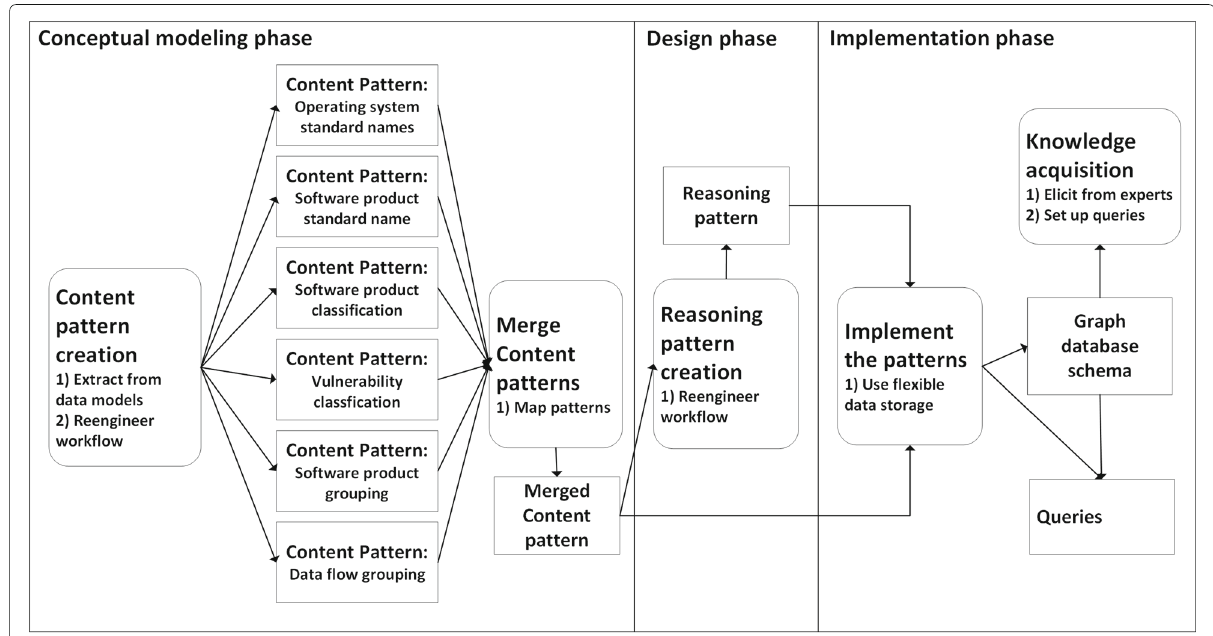
Fig. 2 Ontology framework life cycle from specification to implementation. Operations are represented with rounded blue rectangles and artifacts with normal rectangles